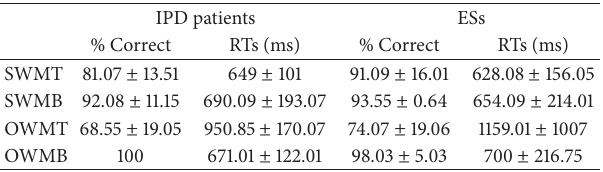
Table 2: Correct responses (%) and RTs (ms) of behavioural performance score (mean ±